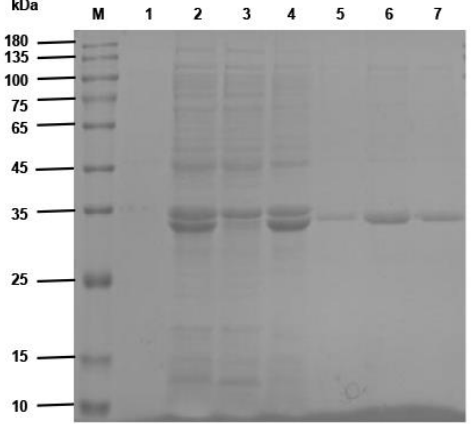
Figure 5. SDS–PAGE analysis of the expression and purification of recombinant BsNb. Recombinant anti-CD20/CD3 BsNb was induced in E. coli and purified by Ni-NTA Sefinose™ Resin. A specific protein band of approximately 32 kDa was observed by SDS–PAGE, which is consistent with the expected molecular weight of anti-CD20/CD3 BsNb. Lane M, Protein Marker (10–180 kDa). Lane 1, bacterial lysate before induction. Lane 2, bacterial lysate after induction. Lane 3, the supernatant of bacterial lysate. Lane 4, precipitate of bacterial lysate. Lanes 5–7, elution of anti-CD20/CD3 BsNb from Ni-NTA Sefinose™